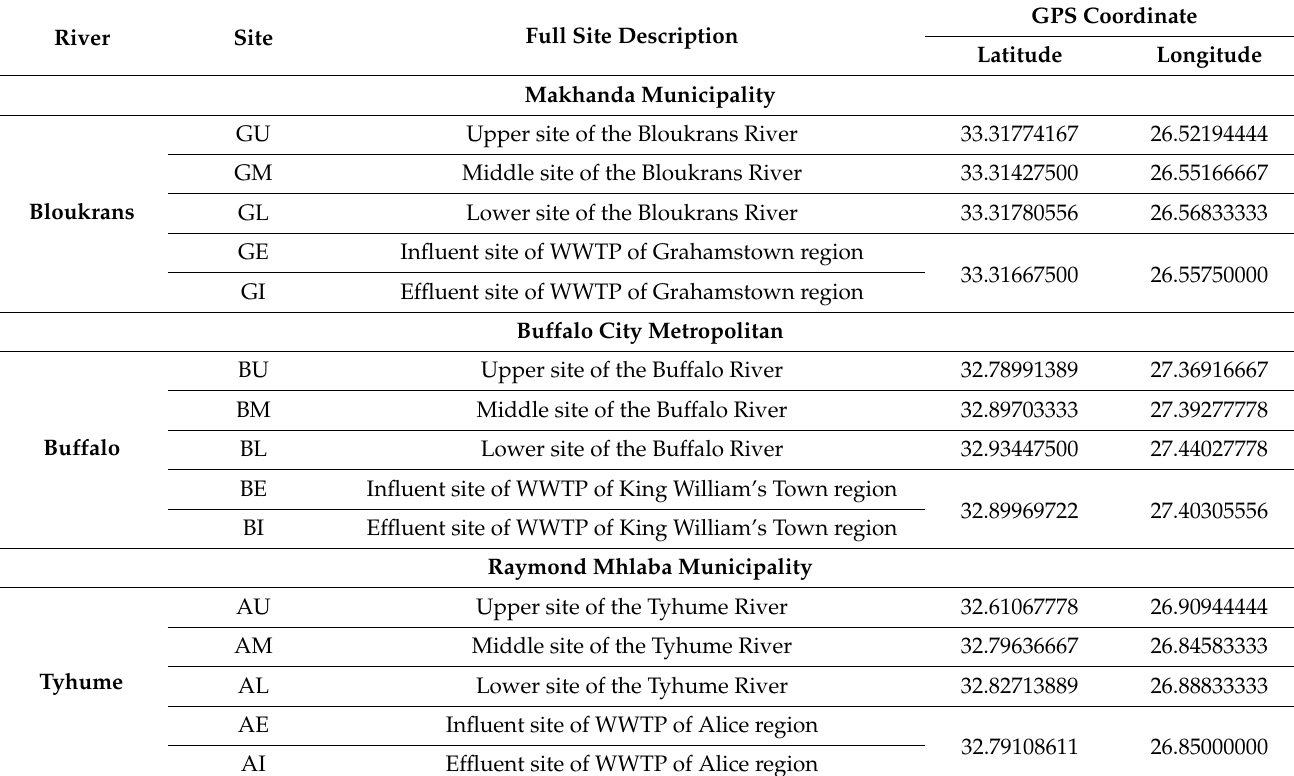
Figure 4. The map of the Buffalo River Catchment demonstrating the study region with sampling sites. Table 1. Descriptive sampling sites and coordinates for rivers and wastewater treatment plants